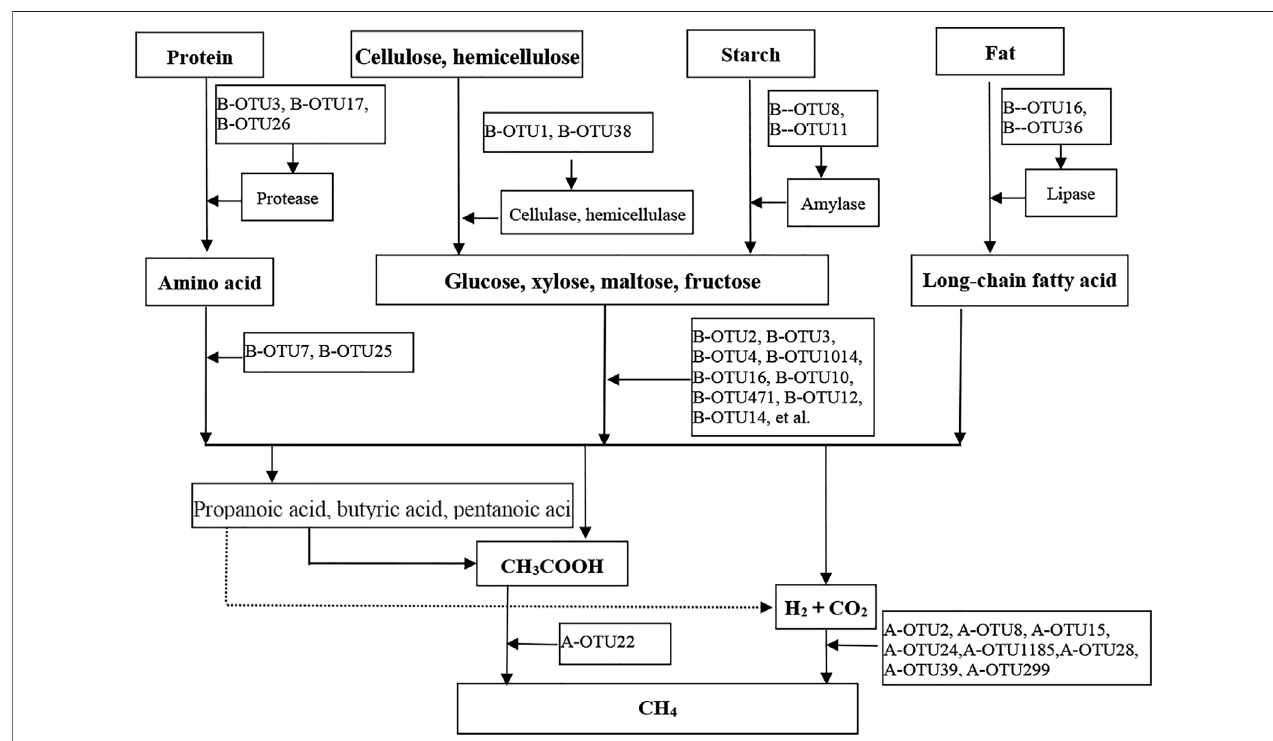
FIGURE 4 | Metabolic pathways for CH 4 production based dominant bacterial OTUs and methanogenic archaeal OTUs.